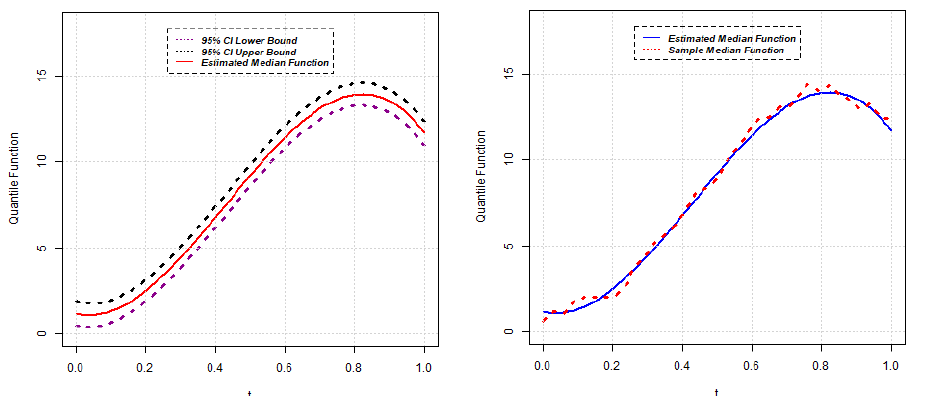
Figure 1. Estimated median function and C.I. ( left ); Estimated median and sample median ( right ) for Model 1.